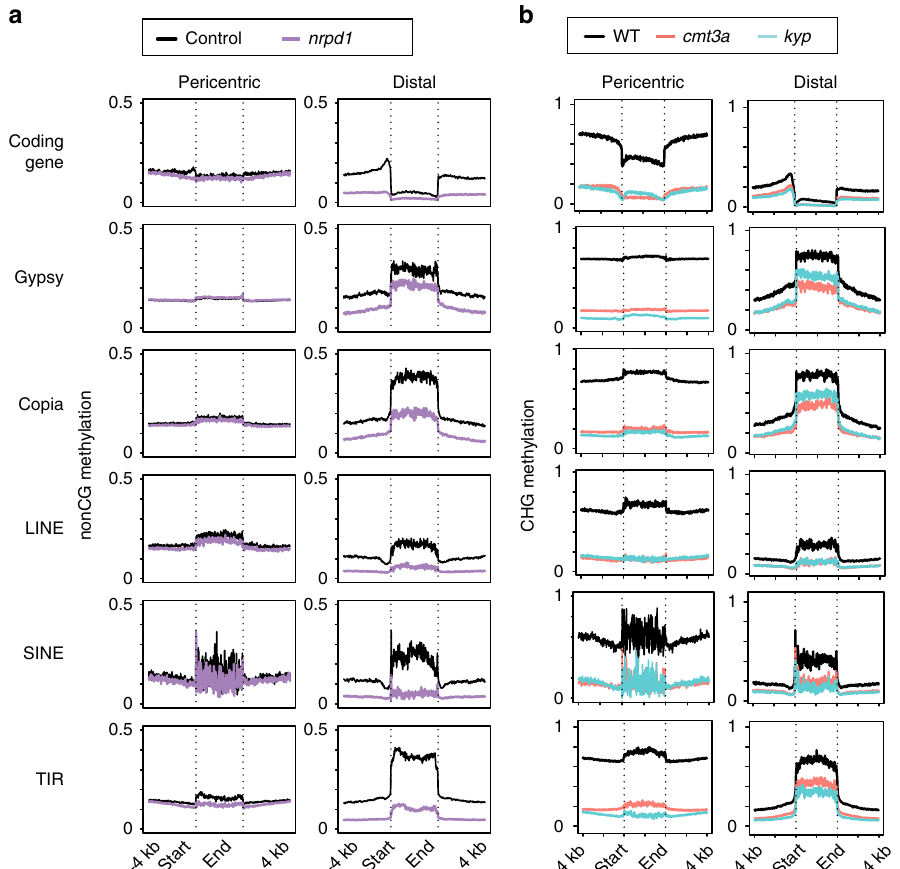
Fig. 2 DNA methylation of TEs in pericentric and distal chromatin. a Average non-CG methylation over coding genes and different TE families in control and nrpd1. b Average CHG methylation in WT, kyp and cmt3a . Distal and pericentric chromatins are plotted separately. Different genomic elements are aligned at the 5 ′ end or the 3 ′ end, and average methylation for all cytosines within each 100 bp interval is plotted. The dotted lines represent the points of alignments of coding-gene transcriptional start site or annotated repeat elements start site and coding-gene transcription termination site or annotated repeat elements end site, respectively. TIR, terminal inverted repeats; LINE, long interspersed nuclear elements; SINE, short interspersed nuclear